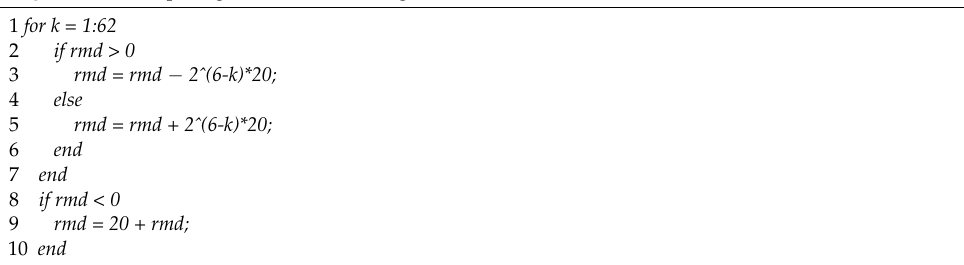
Algorithm 1 Computing the remainder using linear